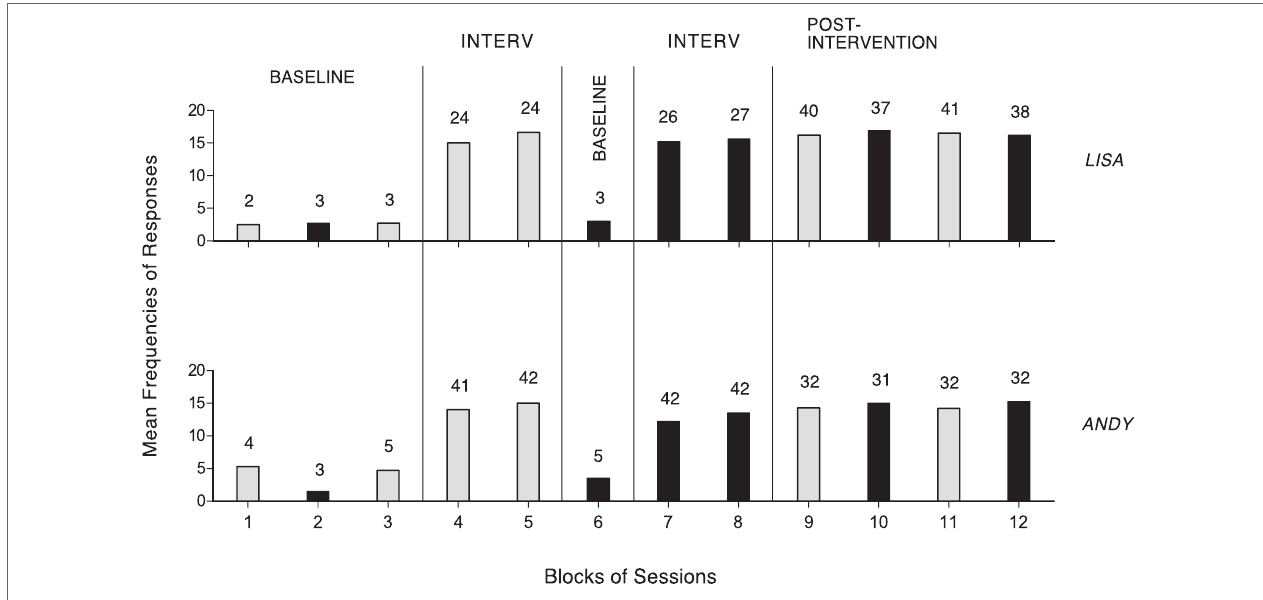
FigUre 3 | The two panels summarize the data for Lisa and Andy. The gray and black bars represent mean frequencies of occurrences per session for the participants’ first response (i.e., right arm stretching) and second response (i.e., trunk forward movements and left arm stretching), respectively. Mean frequencies are plotted as in Figure 1